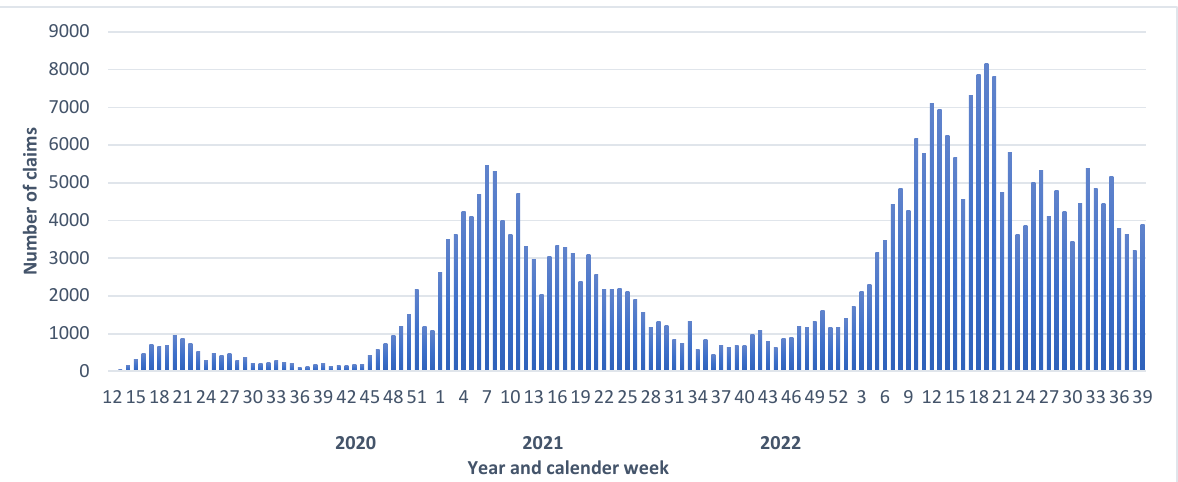
Figure 1. Number of notifiable cases due to COVID-19 from March 2020 to September 2022, separated by calendar week of the notification.